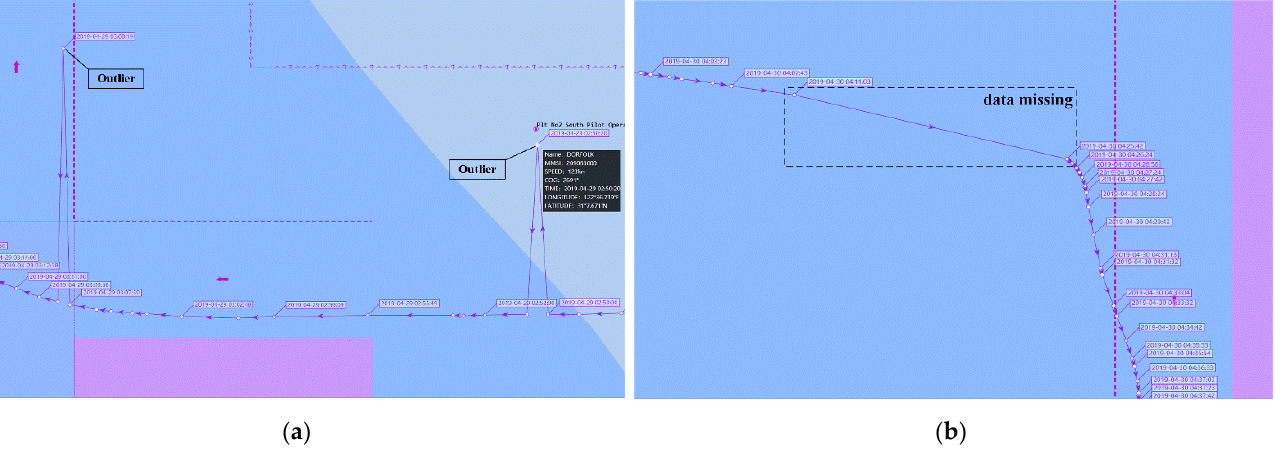
Figure 2. The trajectories with outliers recorded by AIS loggers: ( a ) an AIS trajectory with two noise points; ( b ) an AIS trajectory that suffers from the data missing problem.